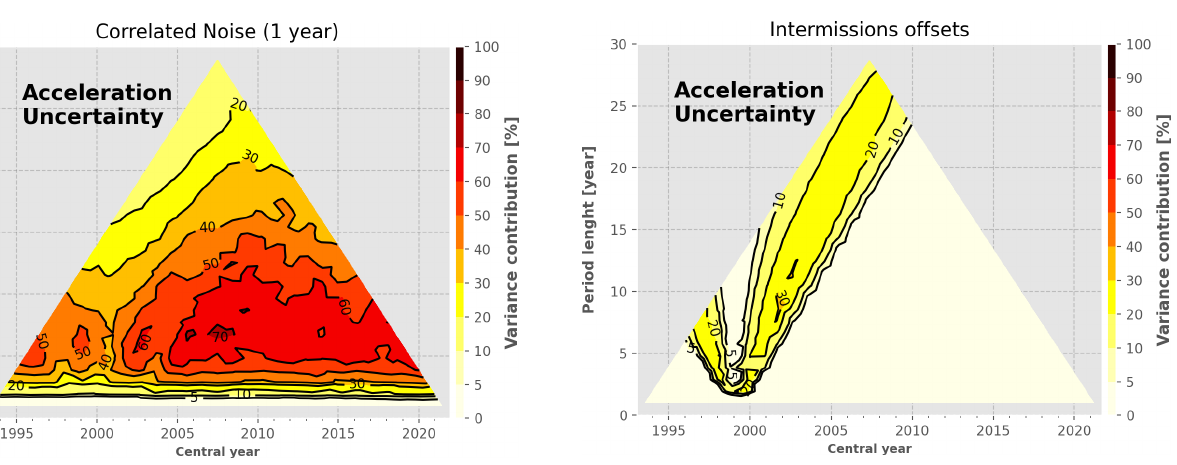
Figure B5. Variance contribution to the GMSL acceleration vari- ance of the intermission offsets.